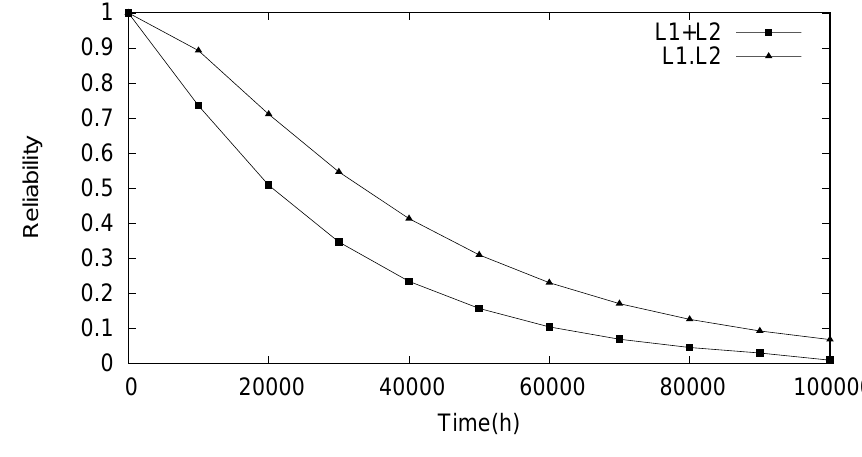
Figure 13. Reliability evaluation for scenario